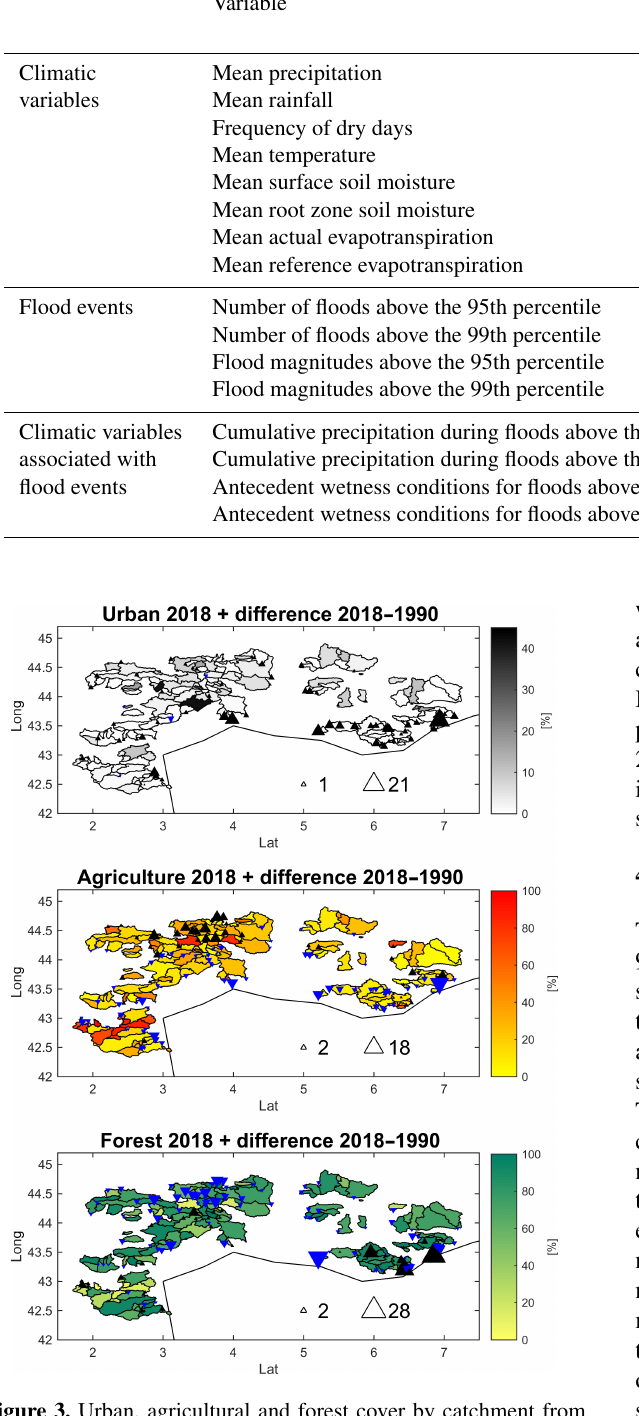
Figure 3. Urban, agricultural and forest cover by catchment from the CORINE database for the year 2018 and differences between 1990 and 2018 (upward black triangles indicate an increase, and downward blue triangles a decrease; the triangle sizes are propor- tional to the absolute changes between 1990 and